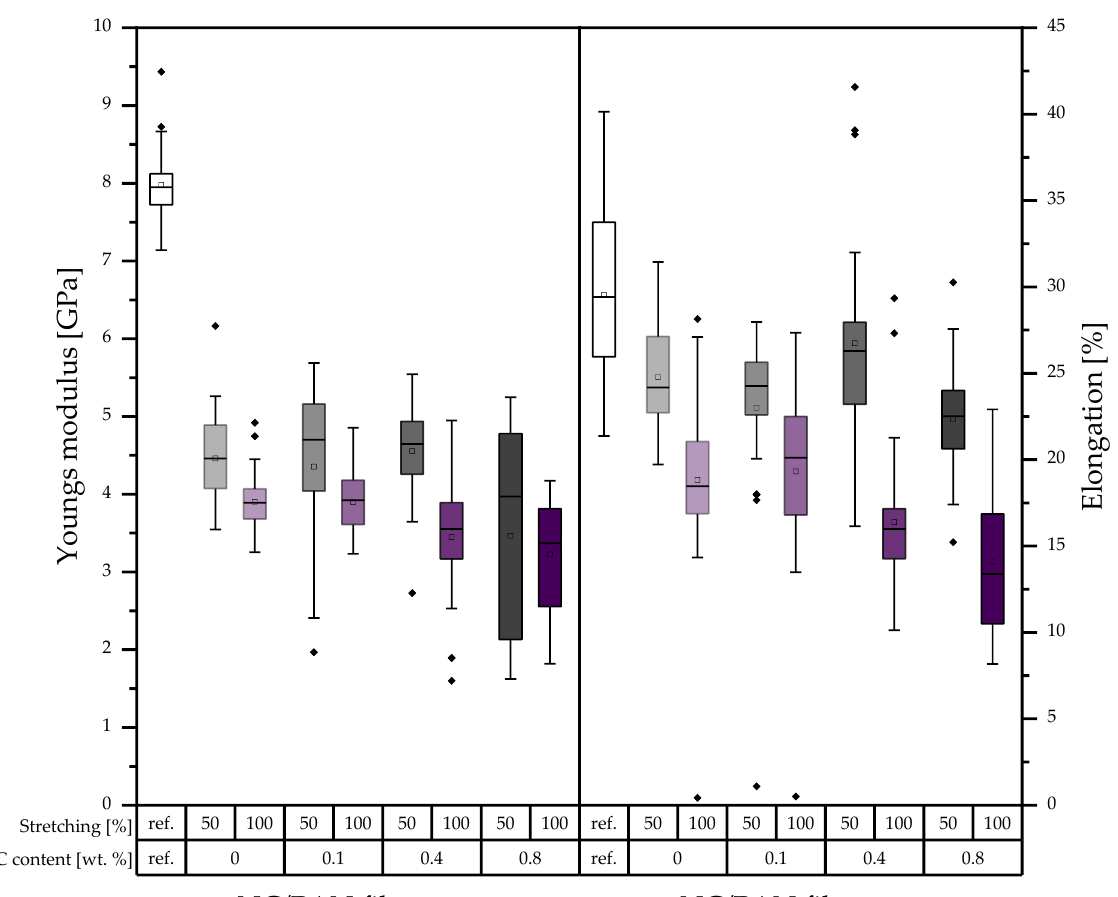
Figure 7. Young ’ s modulus and elongation of the developed porous PAN/NC filaments (in the boxes: sorted values between 25% and 75%; between the whiskers: values within 1.5 · IQR; central line: median; square: mean; and rhombus: outlier).